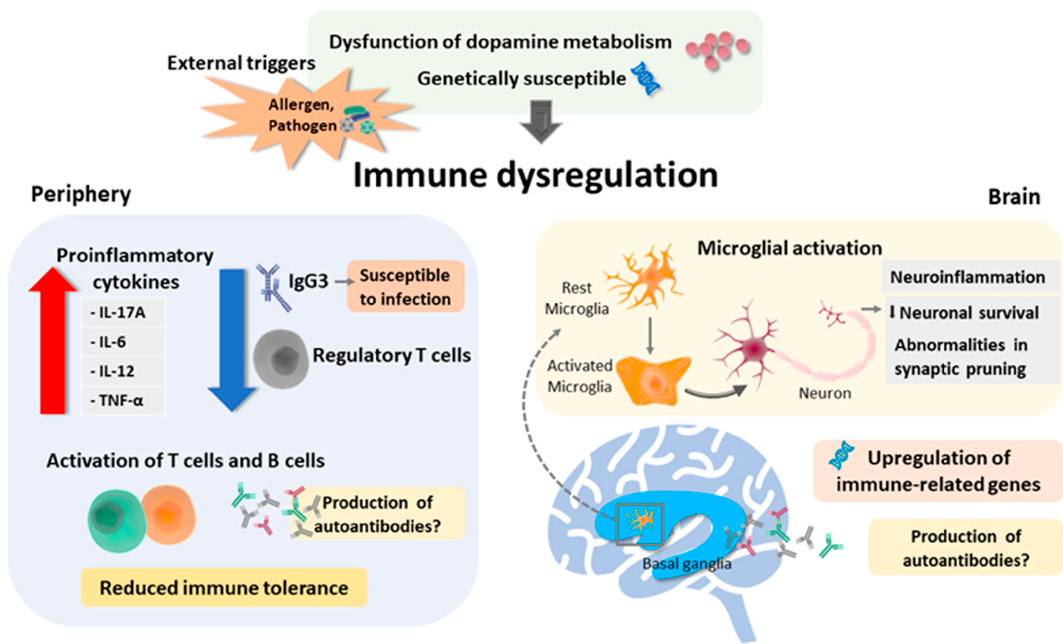
Figure 1. Summary of the possible underlying mechanism leading to immune dysfunction in Tourette syndrome. Predisposing conditions include dysfunction of dopamine metabolism (hyperdopaminergic state) and genetic susceptibility. External triggers such as allergen and pathogen may also, in part, facilitate periphery and brain immune dysregulation. In the periphery, reduced regulatory cells (which might be facilitated by the hyperdopaminergic state), increased release of proinflammatory cytokines, and activation of T-cells and B-cells may lead to reduced immune tolerance. Additionally, the decreased IgG3 level may lead to a defective immune response to pathogens, hence resulting in persistent inflammation. In the brain, regulation of immune-related genes in localized inflammatory microglial activation in the striatum in TS may result in neuroinflammation and additionally affect neuronal survival and abnormalities in neurogenesis. However, the production of any specific pathogenic autoantibody remains to be explored.